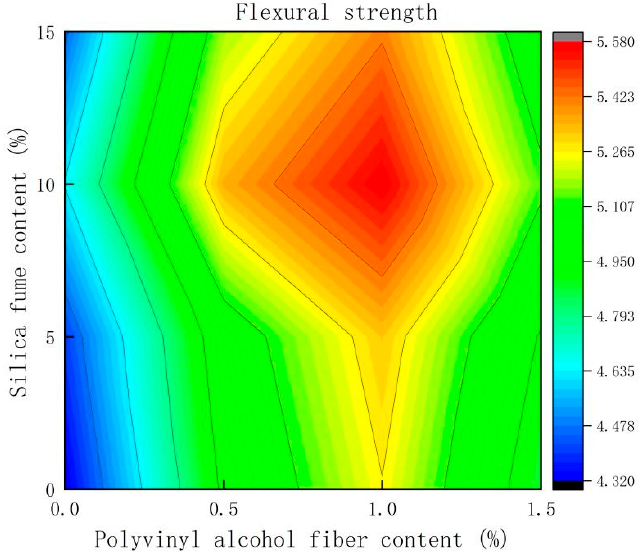
Figure 5. Contour map of flexural strength.